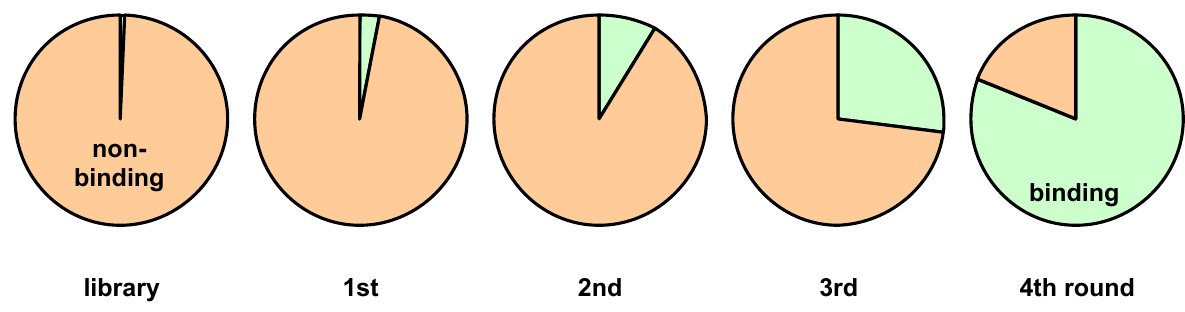
Figure 4. Enrichment of binding phages by affinity selection.